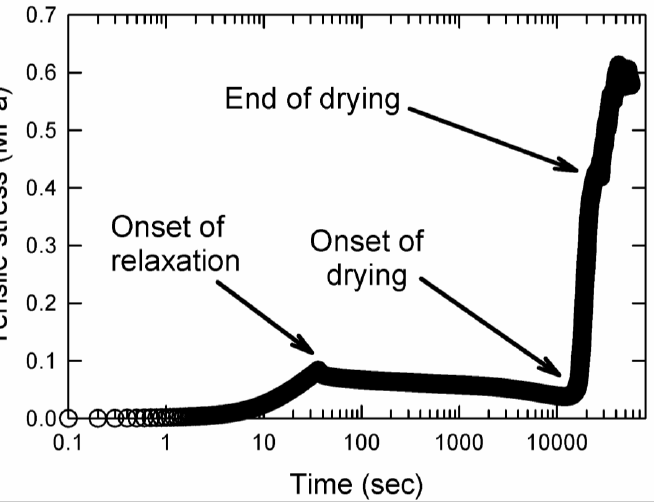
Figure 4. Drying experiment for AMPS(1,2,2,9)/AAm(2,0.1,0.01,97) DN hydrogel stretched to λ = 2. The arrows denote the onset of relaxation, onset of drying and end of drying. Figure 5 shows the AMPS(1,2,2,9)/AAm(2,0.1,0.01,97) DN hydrogels with various extension ratios. All of the